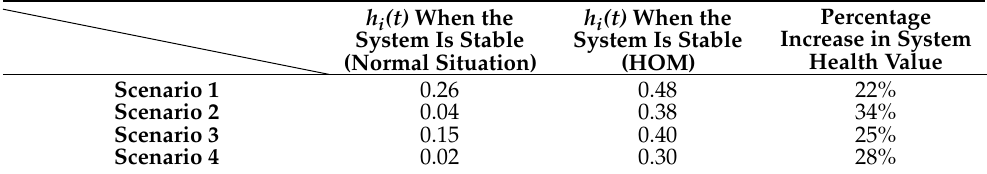
Figure 14. Comparison before and after adding HOM in the fourth scenario: ( a ) h i ( t ) of robots under normal conditions; ( b ) h i ( t ) of robots under HOM; ( c ) e i ( t ) under normal conditions; ( d ) e i ( t ) under HOM. Table 1. Comparison of simulation results in four scenarios before and after adding the HOM algorithm. h i (t) When the System Is Stable (Normal Situation)